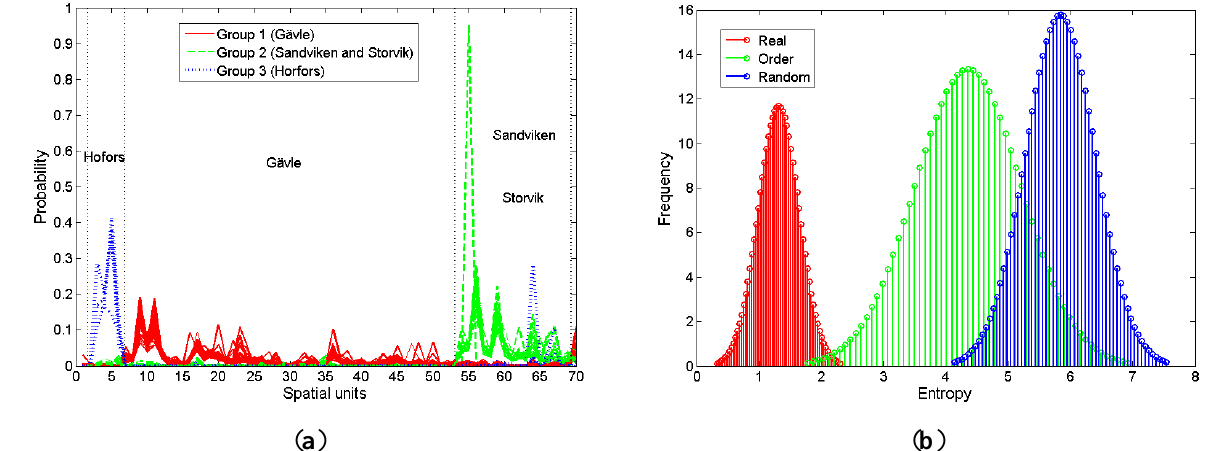
Figure 12. The plot for ( a ) activities distribution in space and ( b ) their entropy